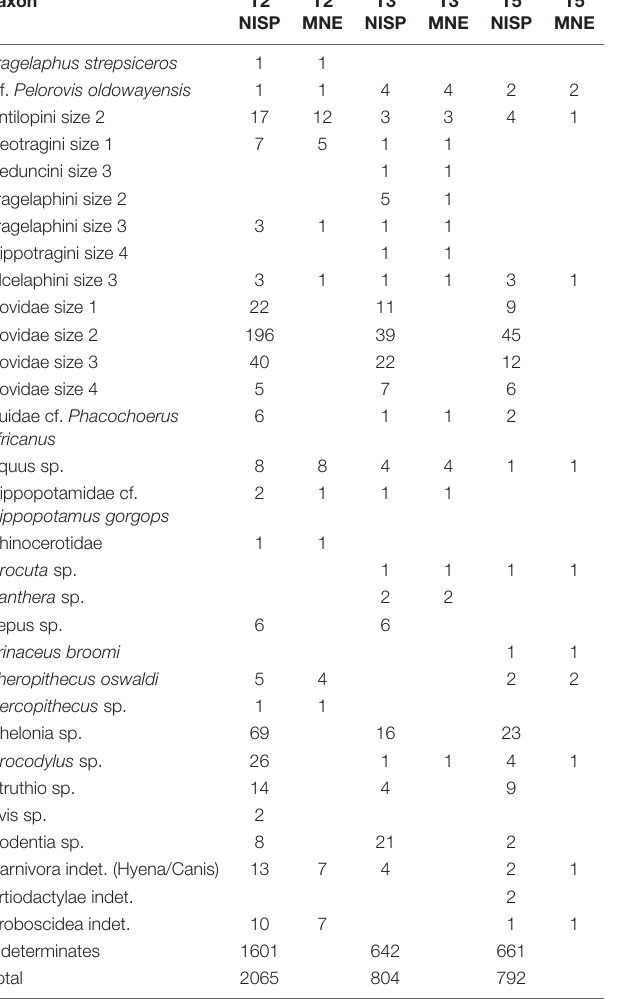
visually indicate that the materials are found in nearby areas. In T3 there is a zone of greater accumulation, although fauna and lithic industry are not completely overlapping. At T5 the overlap appears larger according to visual examination of the Kernel density maps. The results of the Kij(r) function indicate that the accumulation processes of fauna and lithic tools are aleatory and independent in T2, there is a tendency to segregation between the material types in T3, and in T5, although there could be some spatial dependence, there is little statistical significance.